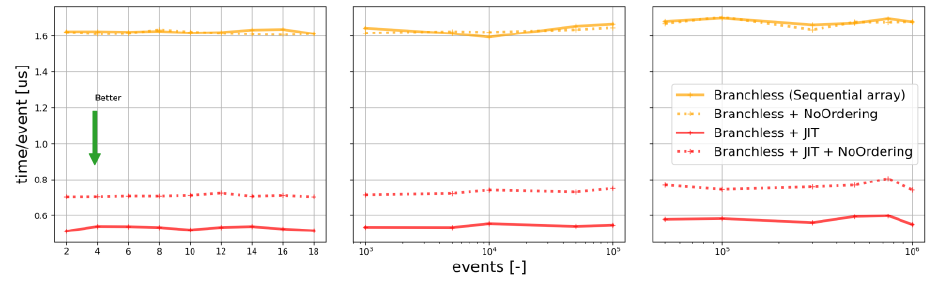
Fig. 5. Speedup in inference by adopting the JIT and the tree ordering techniques.